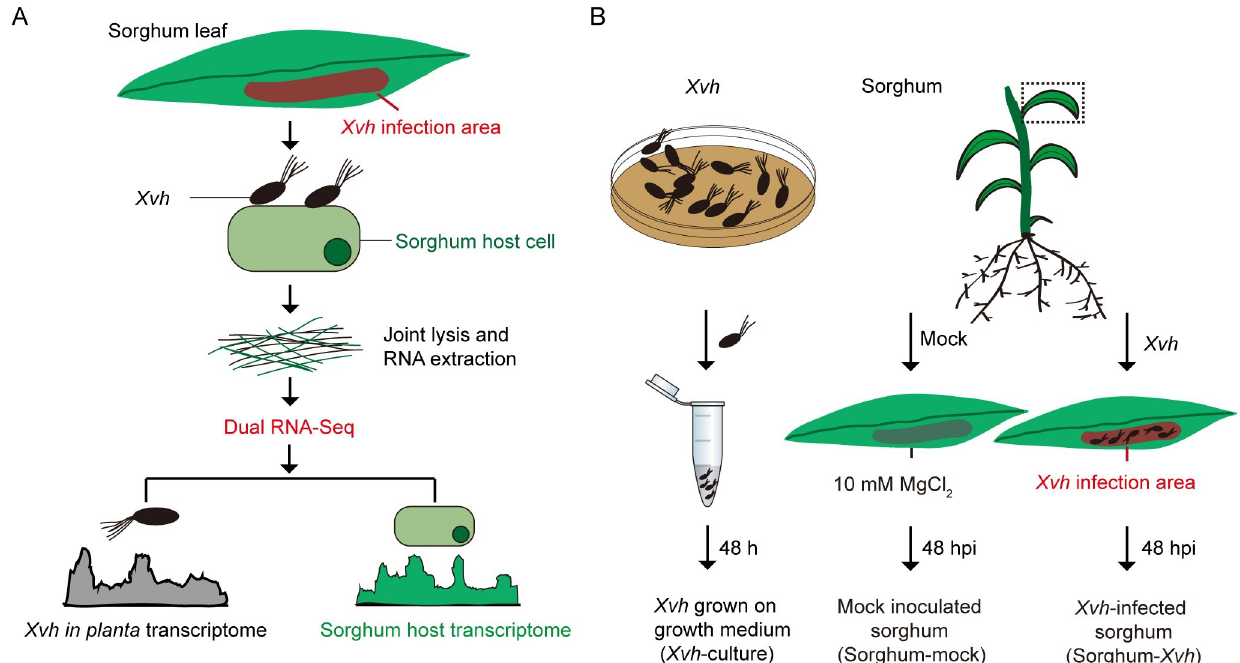
Fig 4. Establishment of dual RNA-Seq for transcriptional analysis of sorghum- Xvh interaction. (A) Workflow of dual RNA-Seq analysis (redrawn and modified from Westermann et al. 2017 [22]). (B) Schematic presentation of the sampling for dual RNA-Seq (see Materials and Methods for further